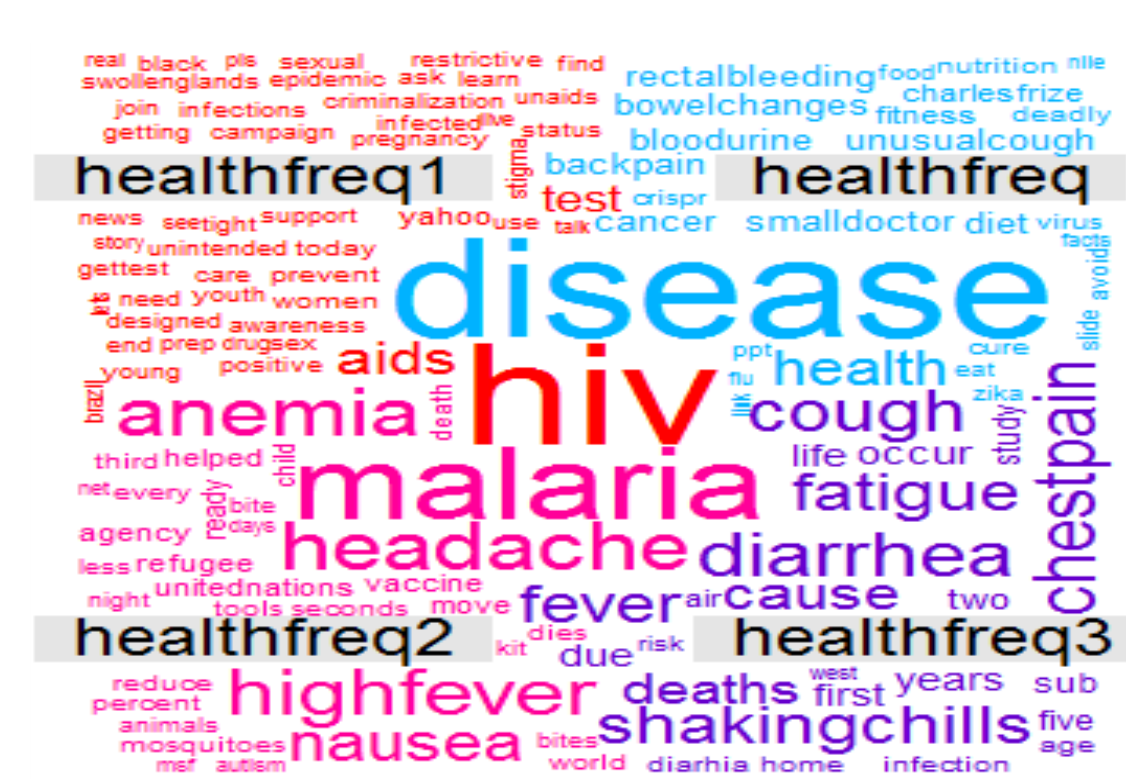
Figure 4 . Commonality WordCloud of frequent occurred health terms